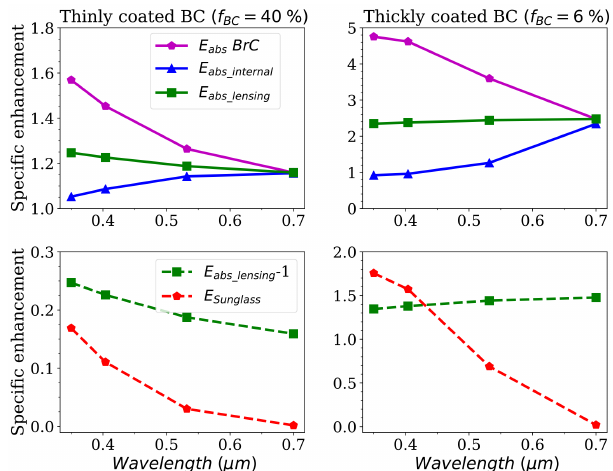
Figure 12. Comparison of BC coated with non-absorbing materi- als and that coated with BrC ( r g =0.06µm, σ g = 1 . 5). D f = 2 . 2 and D f = 2 . 6 were assumed for thinly coated and thickly coated BC,